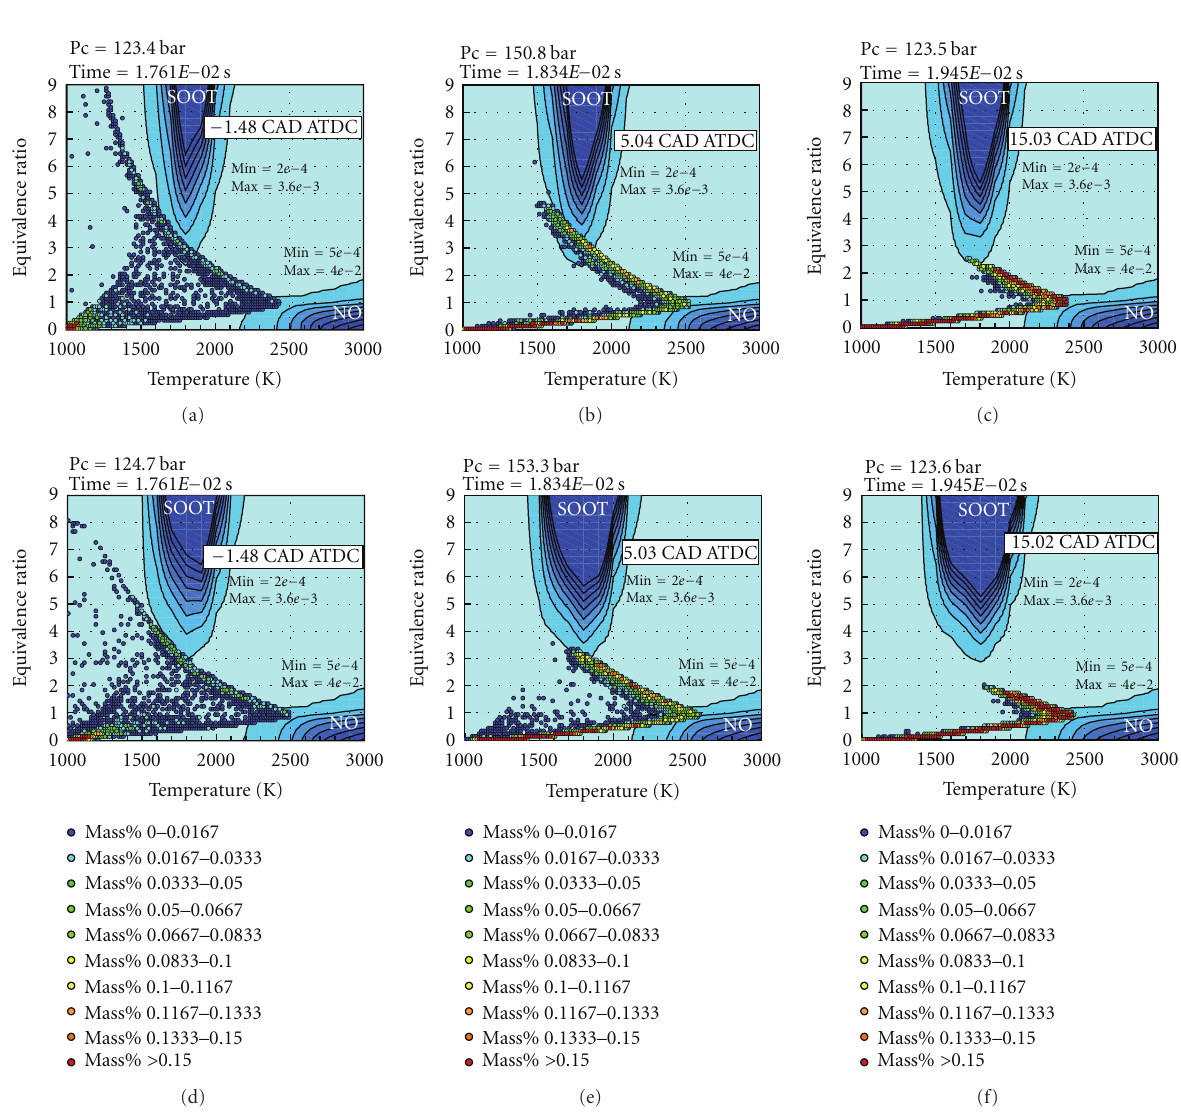
Figure 14: Parametric φ - T emission maps for instant soot and NO concentrations in the Volvo D12C Diesel engine fuelled by DOS (a–c) and RME (d–f) at di ff erent CADs ( − 1.5, 5.0, and 15.0, resp.); the engine was operated under 50% load with 30%